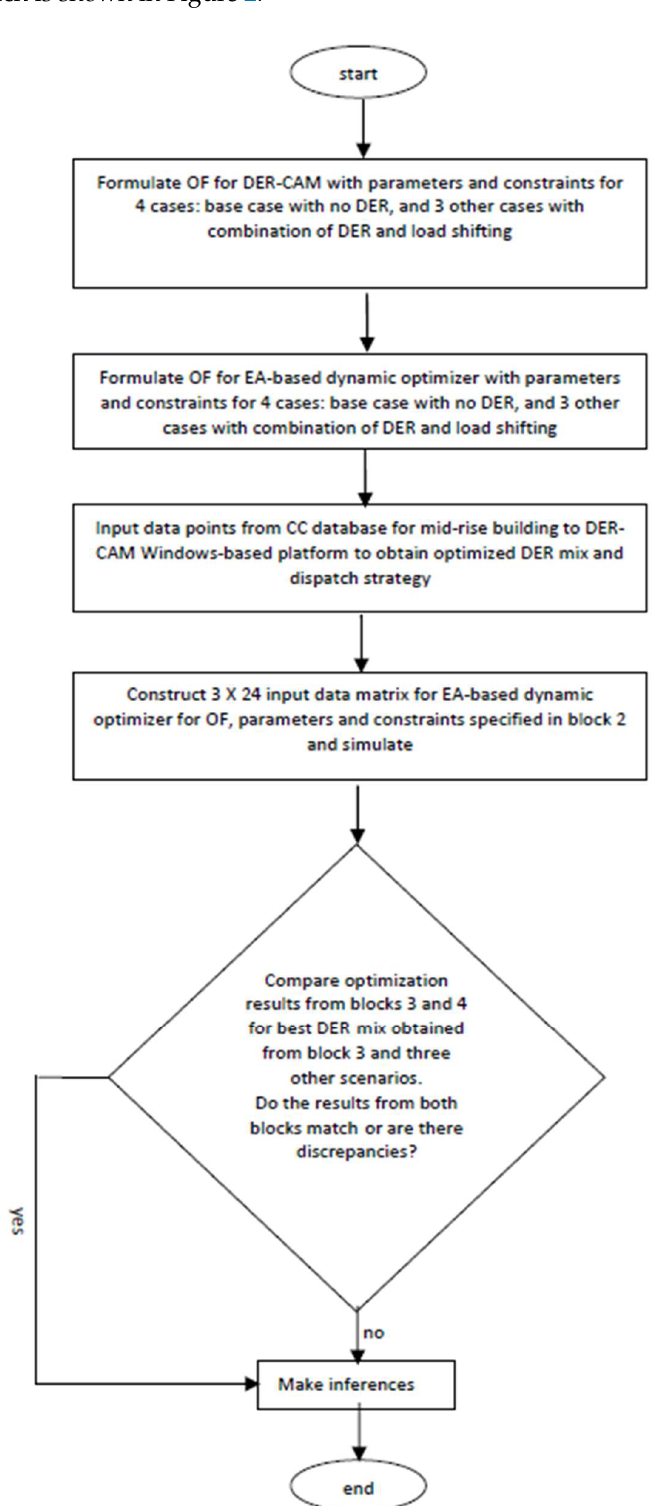
Figure 2. Proposed optimization approach for comparison with distributed energy resources (DER)-CAM optimization.